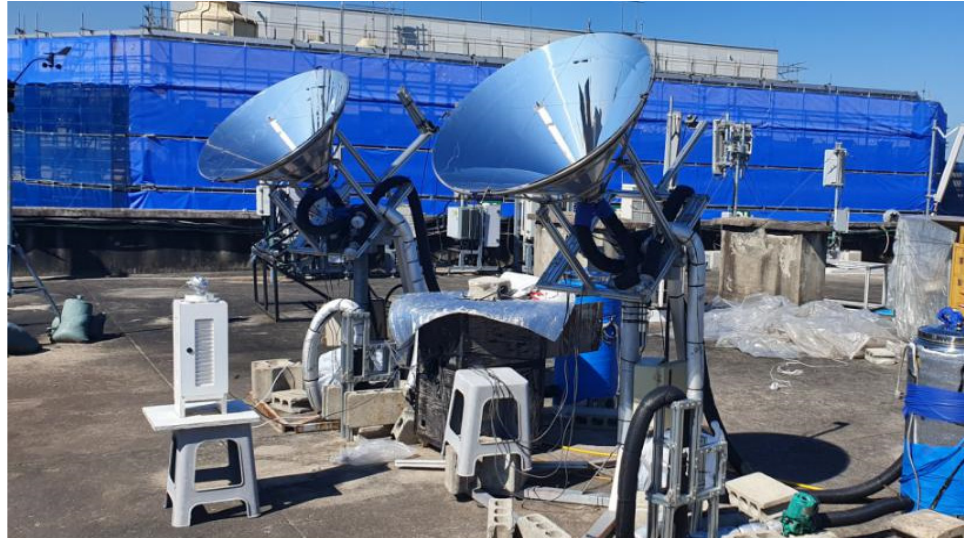
Figure 1. Experimental setup of the conical solar collector system.